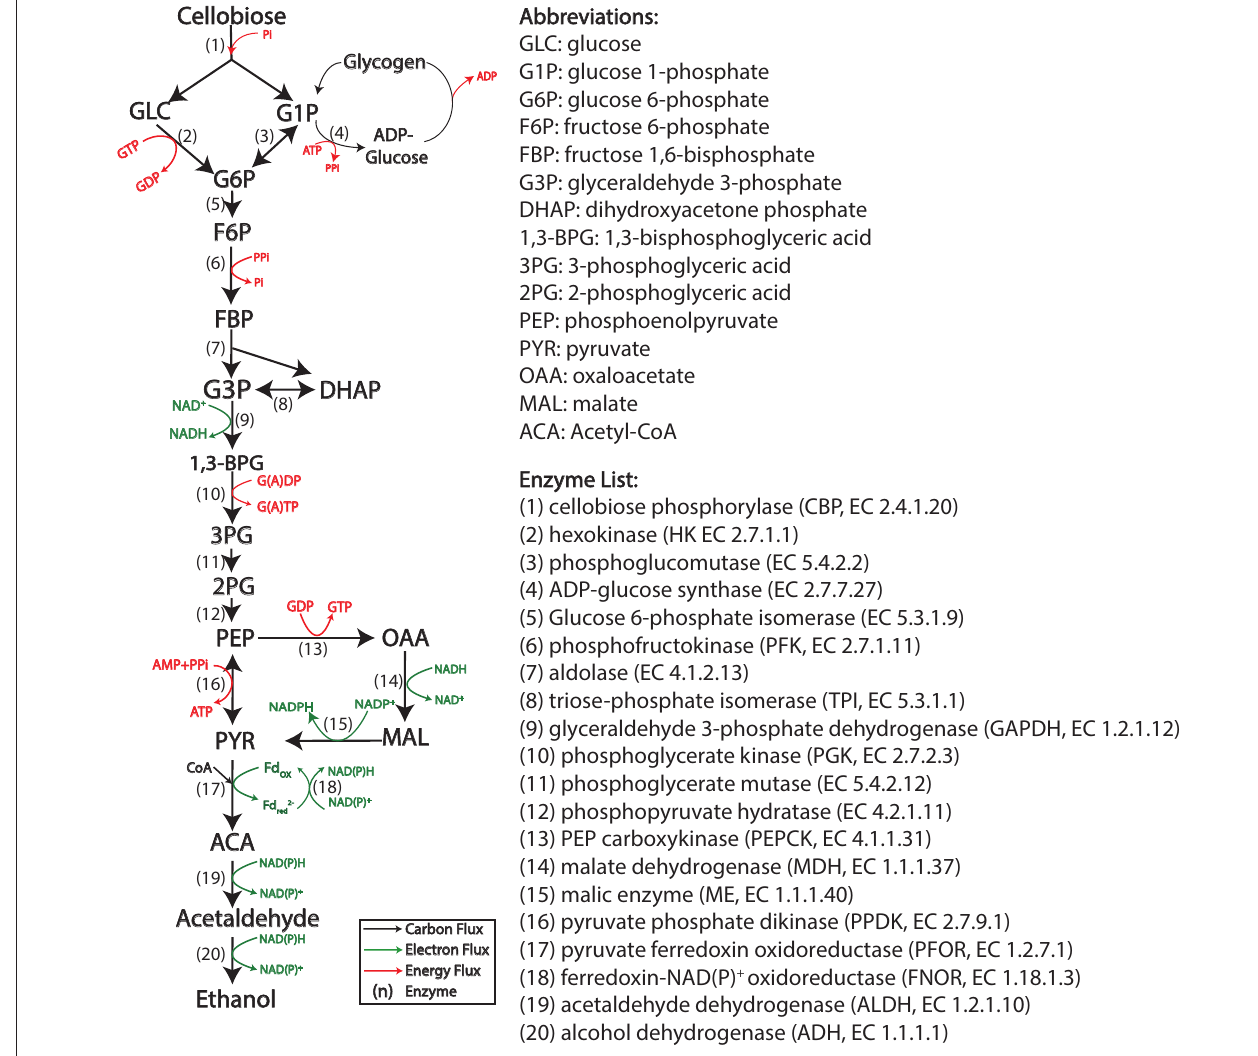
FIGURE 1 | The cellobiose to ethanol pathway in Clostridium thermocellum . Energy cofactors are shown in red, electron carrier cofactors are shown in green. Enzymatic reactions are